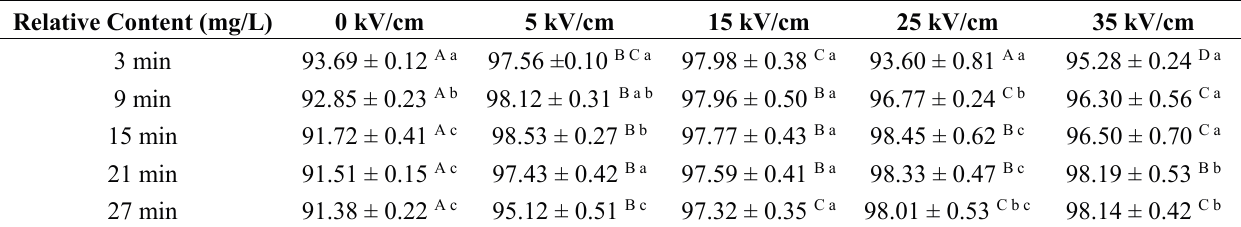
Table 1. The effect of PEF treatment on the relative content of VIT-C as detected by HPLC. Relative Content (mg/L) 0 kV/cm 5 kV/cm